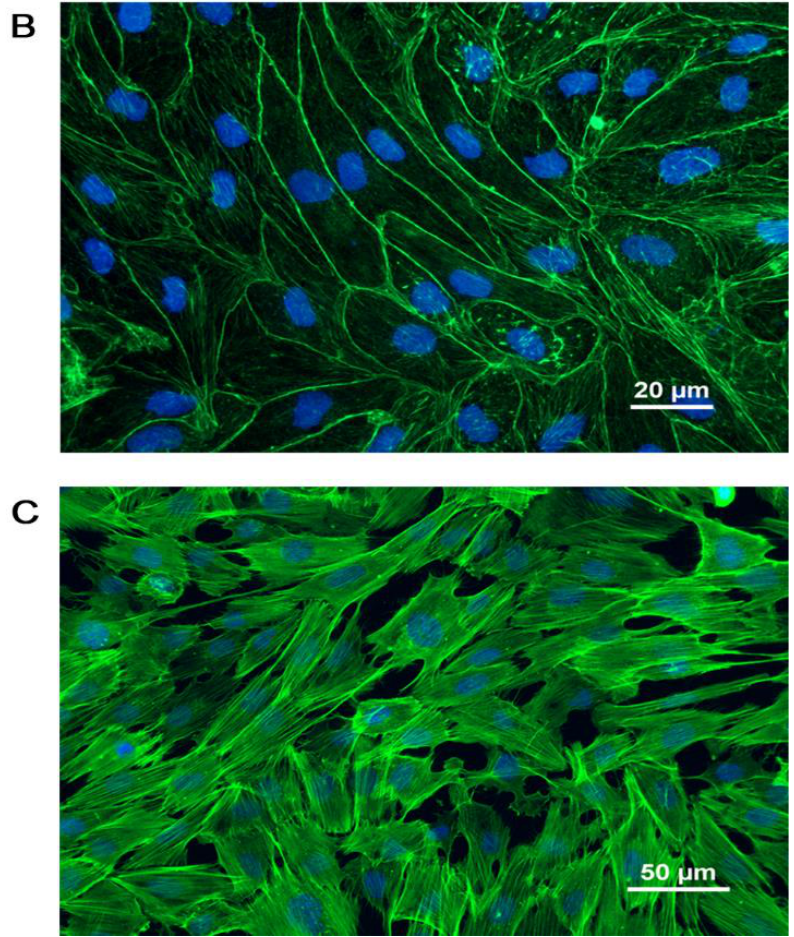
Figure 1. Brain capillary endothelial cells. ( A ) Schematic drawing of the in-vitro BBB culture system used. PBEC were cultured on collagen coated Transwell inserts to gain typical BBB-like characteristics. ( B , C ) Immunocytochemistry of the two types of brain endothelial cells used: PBEC ( B ) and the human cell line hCMEC/D3 ( C ). Cells were stained for F-actin using Alexa Fluor 488-conjugated phalloidin (green). Nuclei were counterstained with Hoechst.